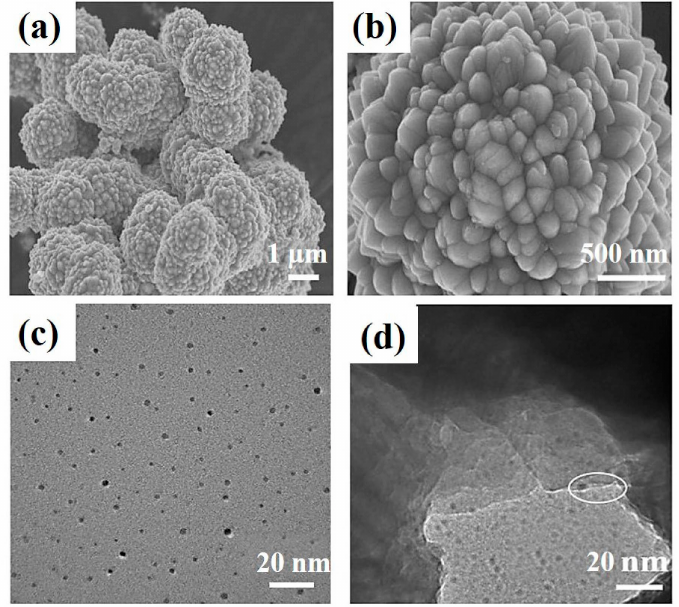
Figure 1. ( a , b ) SEM image of Zn 0.2 Cd 0.8 S; ( c ) TEM image of CDs; ( d ) TEM image of Zn 0.2 Cd 0.8 S@CDs.